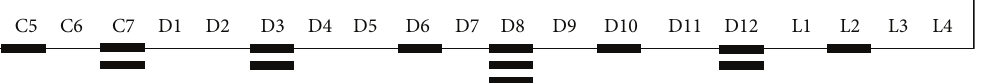
Figure3:Occurrenceofvertebralmassesatdifferentvertebrallevels.Analysisof13newlydiagnosedMMpatientsfollowedattheHematology Unit, Rimini Hospital,